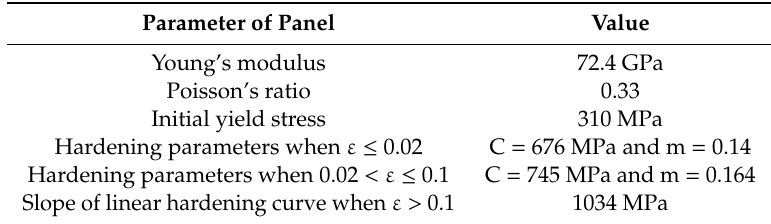
Table 2. Material properties for 2024-T3 aluminum alloy plates [9].